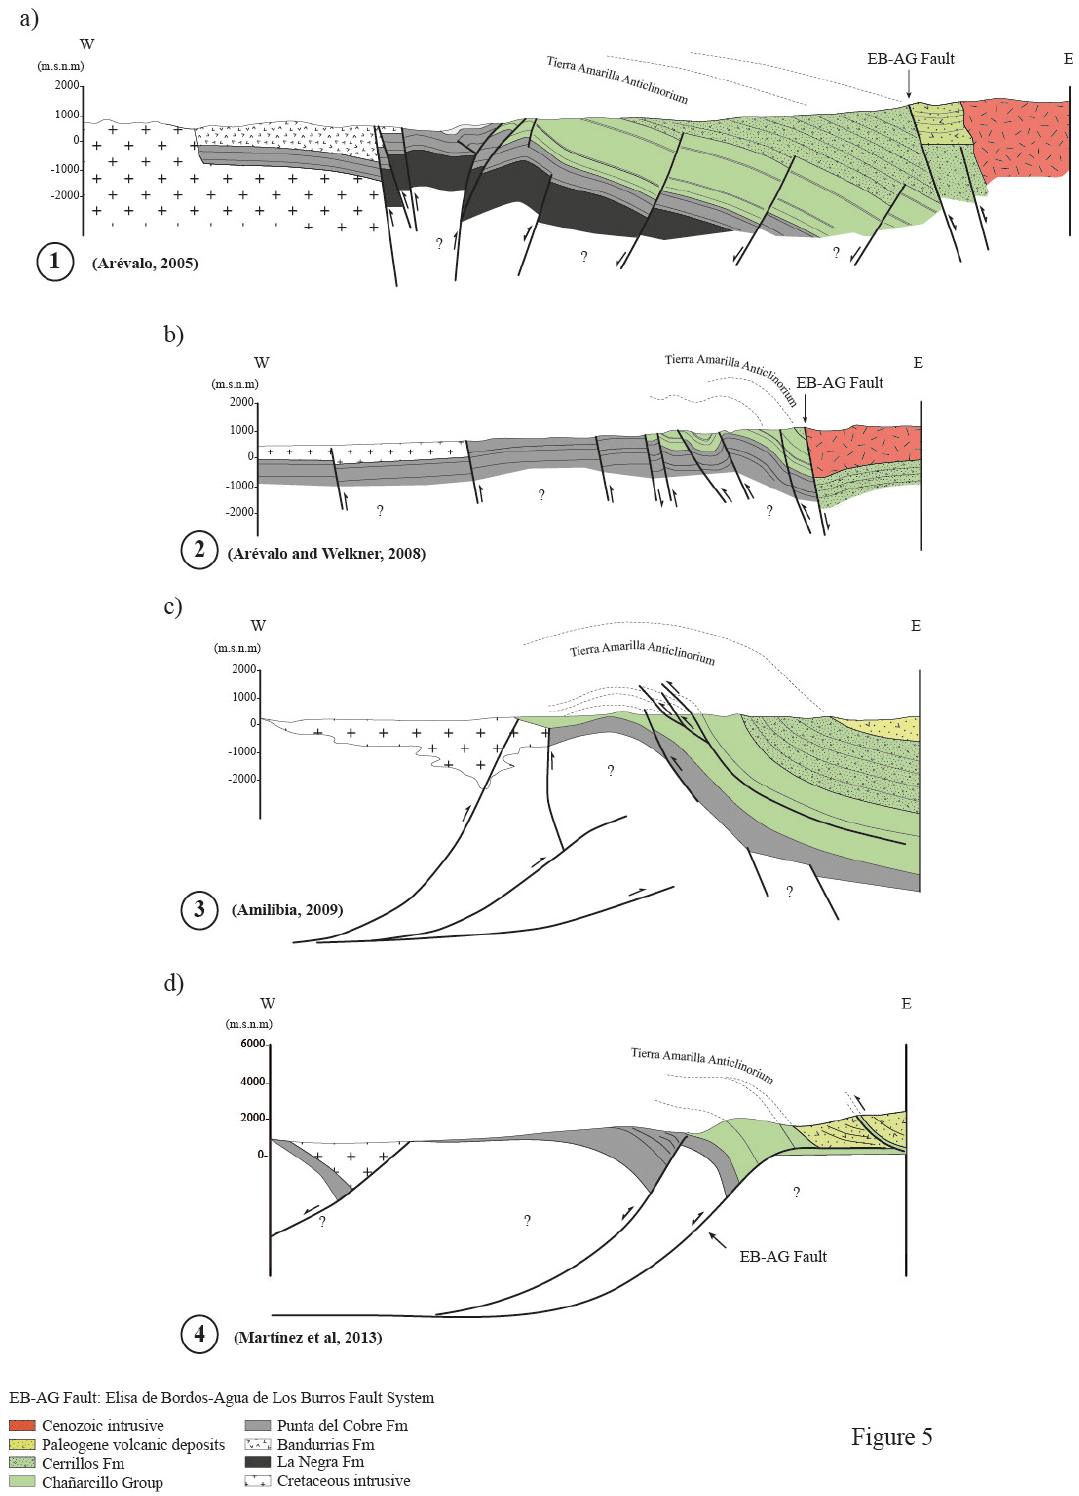
Figure 5. Structural models proposed to explain the architecture of the Chañarcillo Basin, as well as the relationship between the Tierra Amarilla Anticlinorium and the Elisa de Bordos–Agua de Los Burros Fault System (see description in